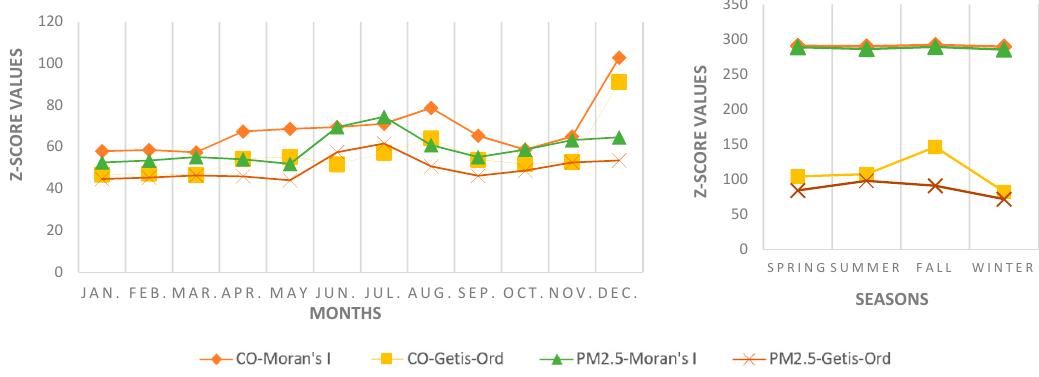
Figure 2. Monthly and seasonal Z -score values for carbon monoxide (CO) and fine particulate matter (PM 2.5 ).